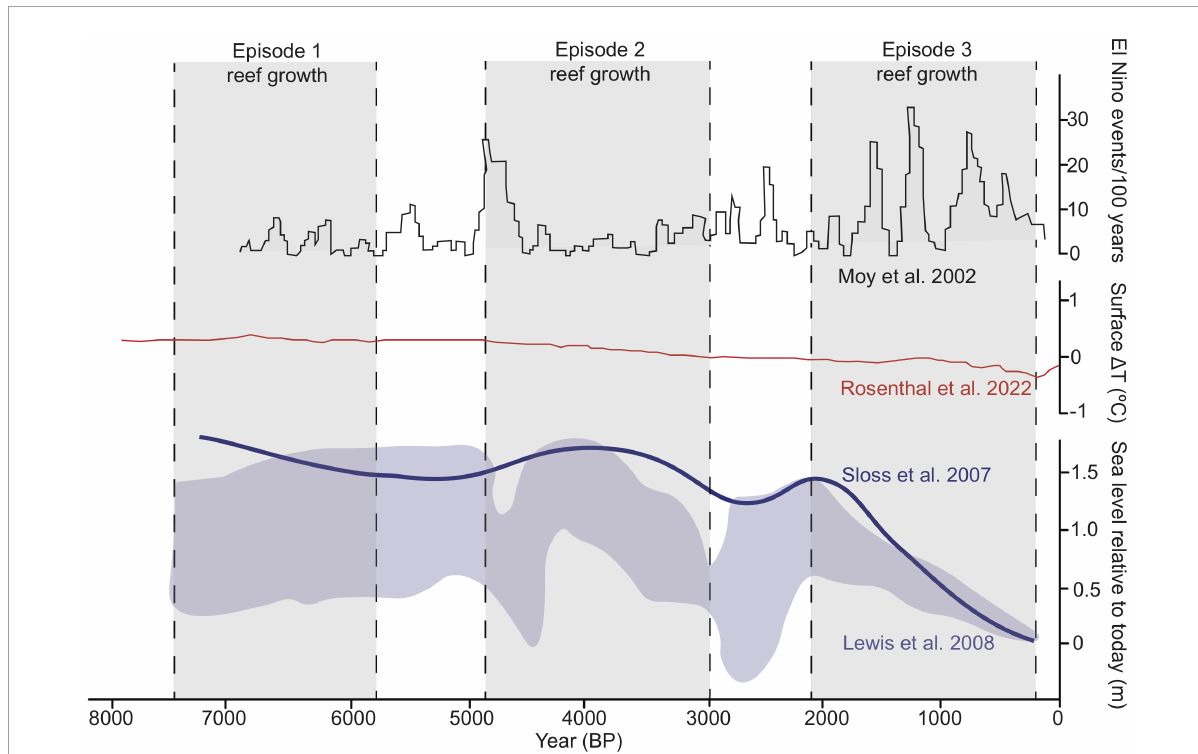
FIGURE7 Composite representation of selected environmental variables from eastern Australia and the greater Pacific Ocean during the past ∼ 7,000 years. Sea level curves of Sloss et al. (2007) and Lewis et al. (2008) were re-scaled to the same elevation datum. Holocene reconstruction of surface water temperature anomalies from Rosenthal et al. (2022) are a global average. ENSO frequency record of Moy et al. (2002) was recorded from sediments from southern